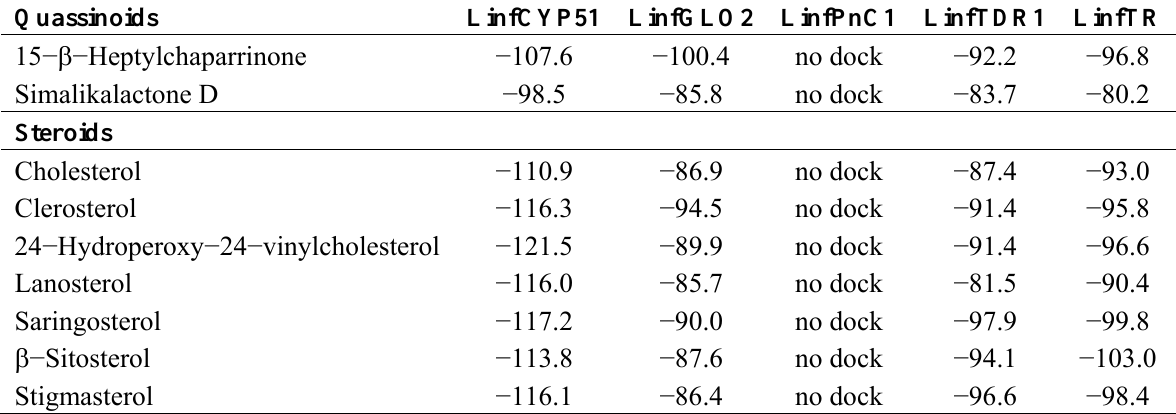
Table 40. MolDock docking energies (kJ/mol) of quassinoids and steroids with Leishmania infantum protein targets.